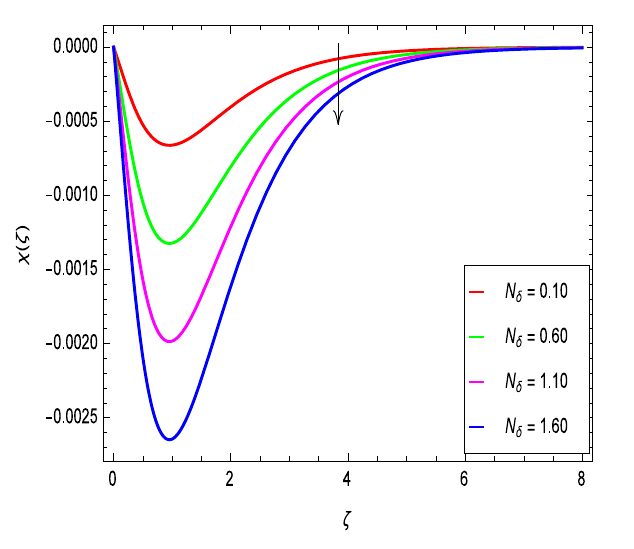
Figure 25. χ(ζ) in terms of N δ